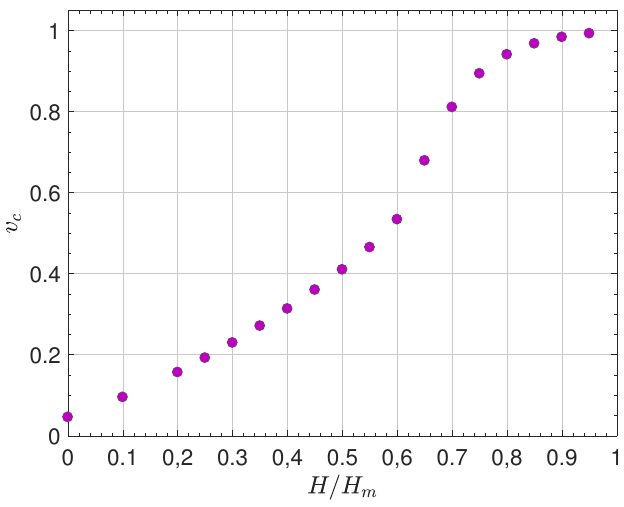
Figure 12 . Φ 2+ ( x ) antikink scattering with φ 1 boundary: critical velocity v c as a function of H . For v i > v c there is no possibility of formation of a travelling kink at the boundary (see also figure